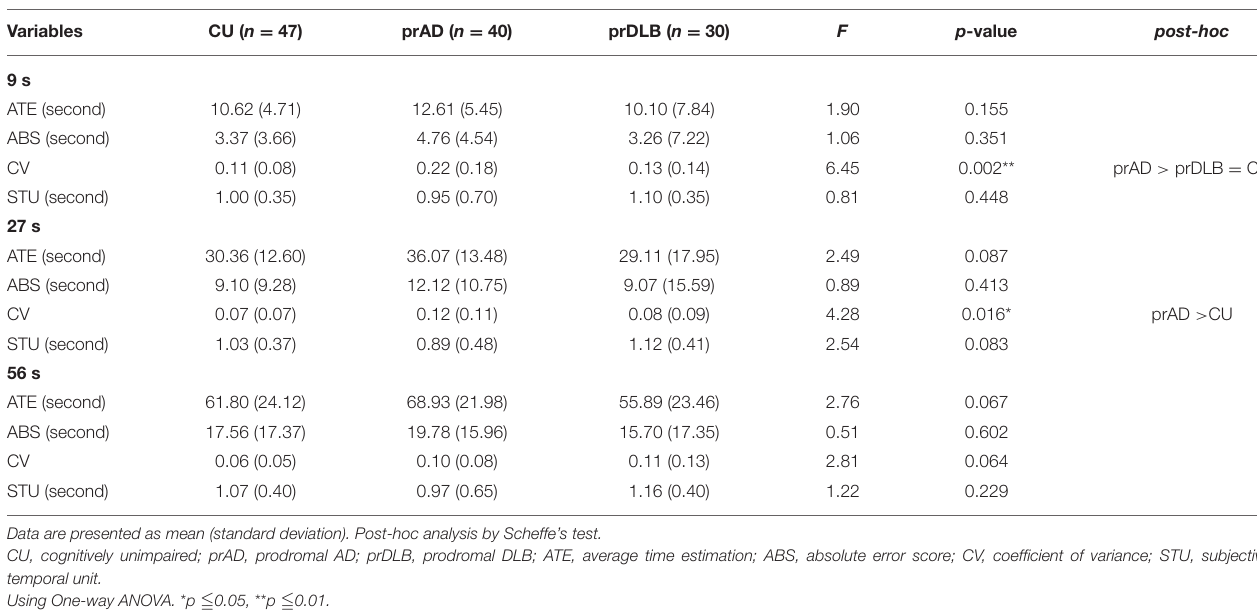
TABLE 3 | Verbal estimation test.